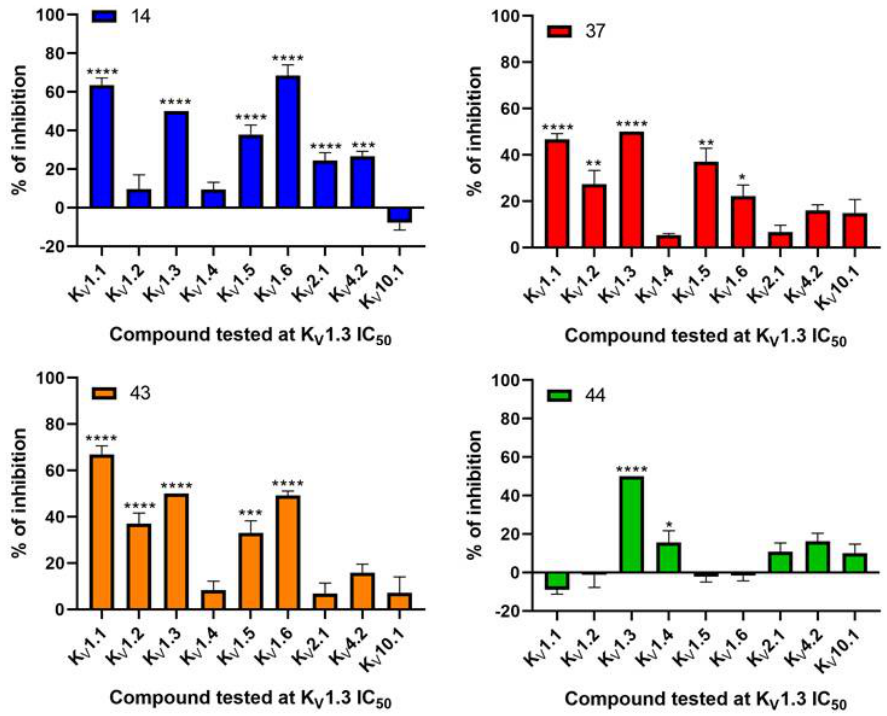
Figure 5. Selectivity determination of 14 , 37 , 43 , and 44 screened at a concentration of their IC 50 values for K V 1.3 on a panel of ion channels. **** p < 0.0001, *** p < 0.001, ** p < 0.01 * p < 0.05, Mean ± S.E.M, N = 3–12). Table 4. IC 50 values [µM] for analogs PAP-1 , 14 , 37 , 43 , and 44 on relevant voltage-gated ion chan- nels. IC 50 values were determined with HiClamp Xenopus laevis heterologous expression system for